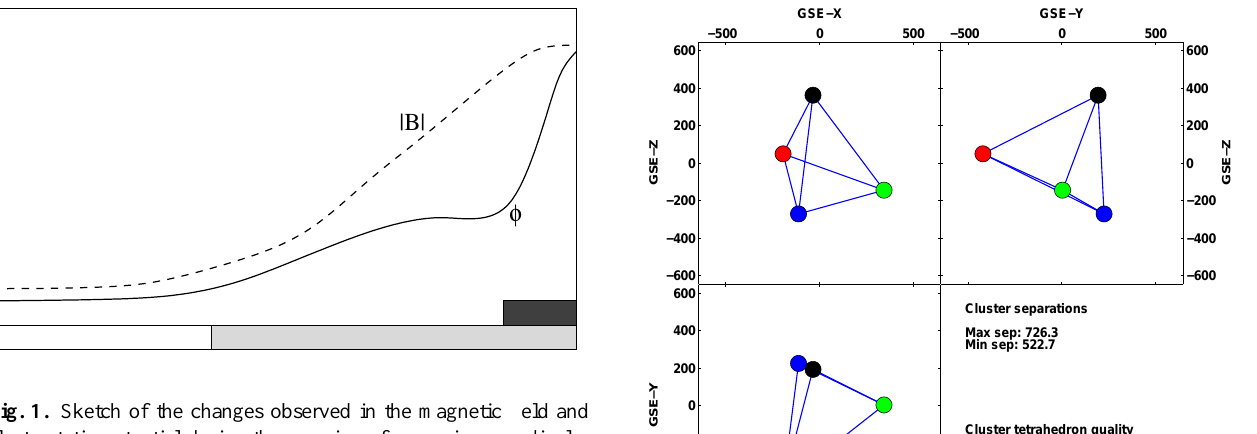
Fig. 1. Sketch of the changes observed in the magnetic field and electrostatic potential during the crossing of a quasi-perpendicular shock (based upon the experimental results of Eselevich et al. (1971)).